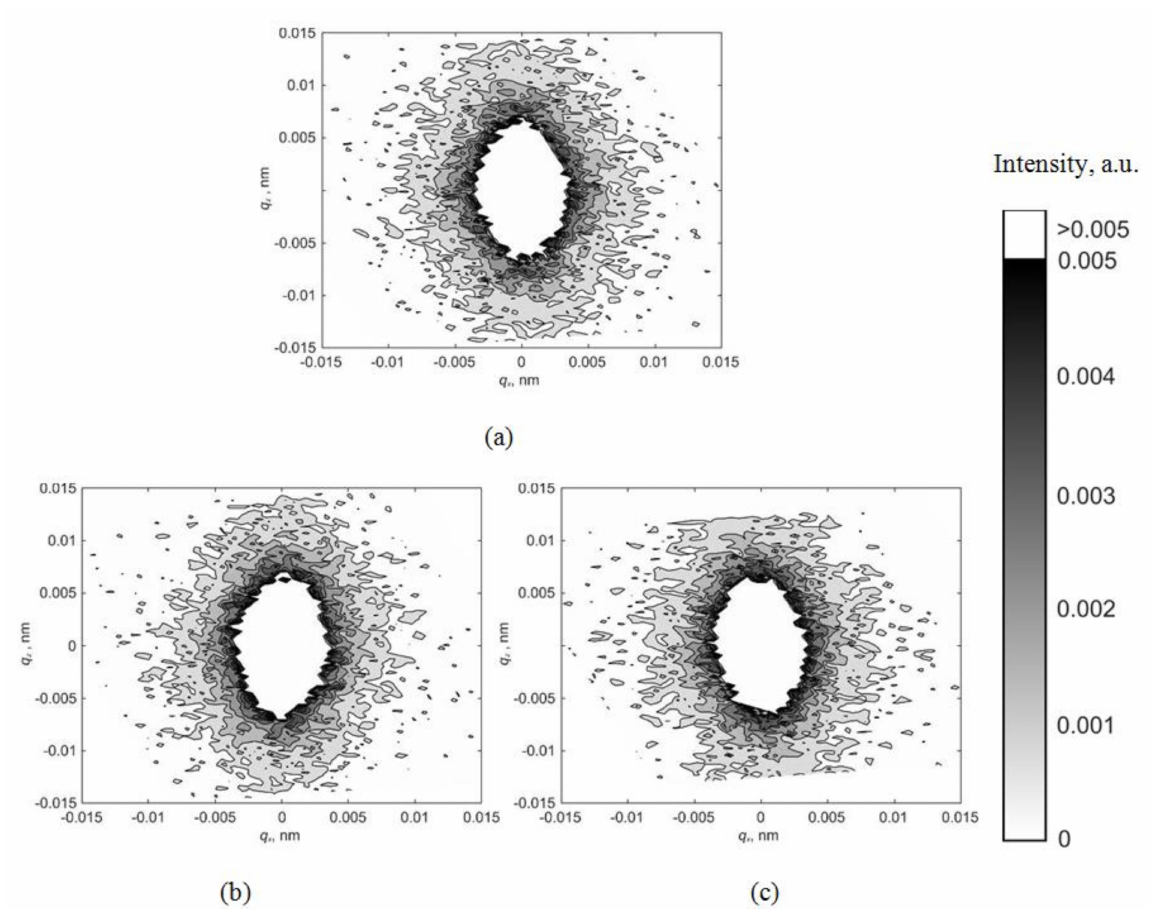
Figure 5. Maps of the symmetric part of diffuse scattering for reflections (220) at various values of applied electric voltage ( a ) 0 V; ( b ) − 2000 V; ( c ) +2000